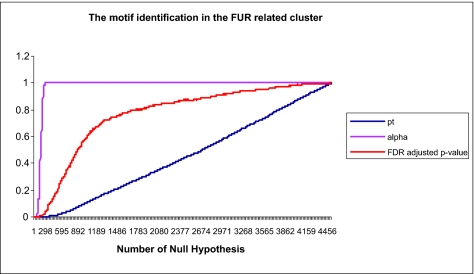
The plot of FDR adjusted p-value, experiment-wise type I error (FWER)(alpha) and comparison-wise type I error (CWER)(pt) in the fur-related cluster in a time series gene expression experiment in S.typhimurium with 3886 motif-gene expression combinations. The x-axis is the number of hypotheses rejected and the y-axis is he probability level for the different statistical tests.